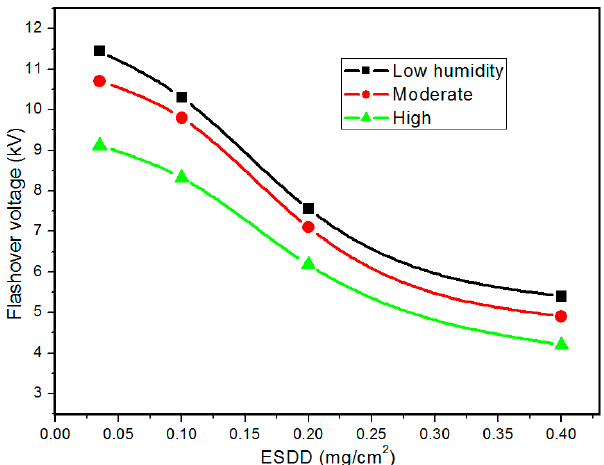
Figure 14. Flashover voltage at different humidity levels, where pollution distribution = uniform, NSDD = 0.75 mg/cm 2 , temperature = 10 °C, and standard deviation = 3.1%–5.8%.